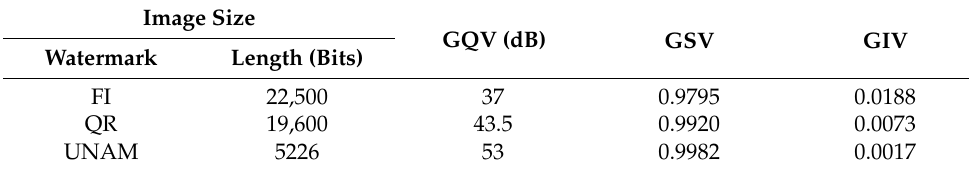
Figure 10. Watermarked UCID graphical quality degradation and imperceptibility. ( a – c ) are the corresponding PSNR, SSIM, and NCD for the FI watermark; ( d – f ) are the corresponding PSNR, SSIM, and NCD for the QR watermark; ( g – i ) are the corresponding PSNR, SSIM, and NCD for the UNAM watermark. Table 5. General performance for